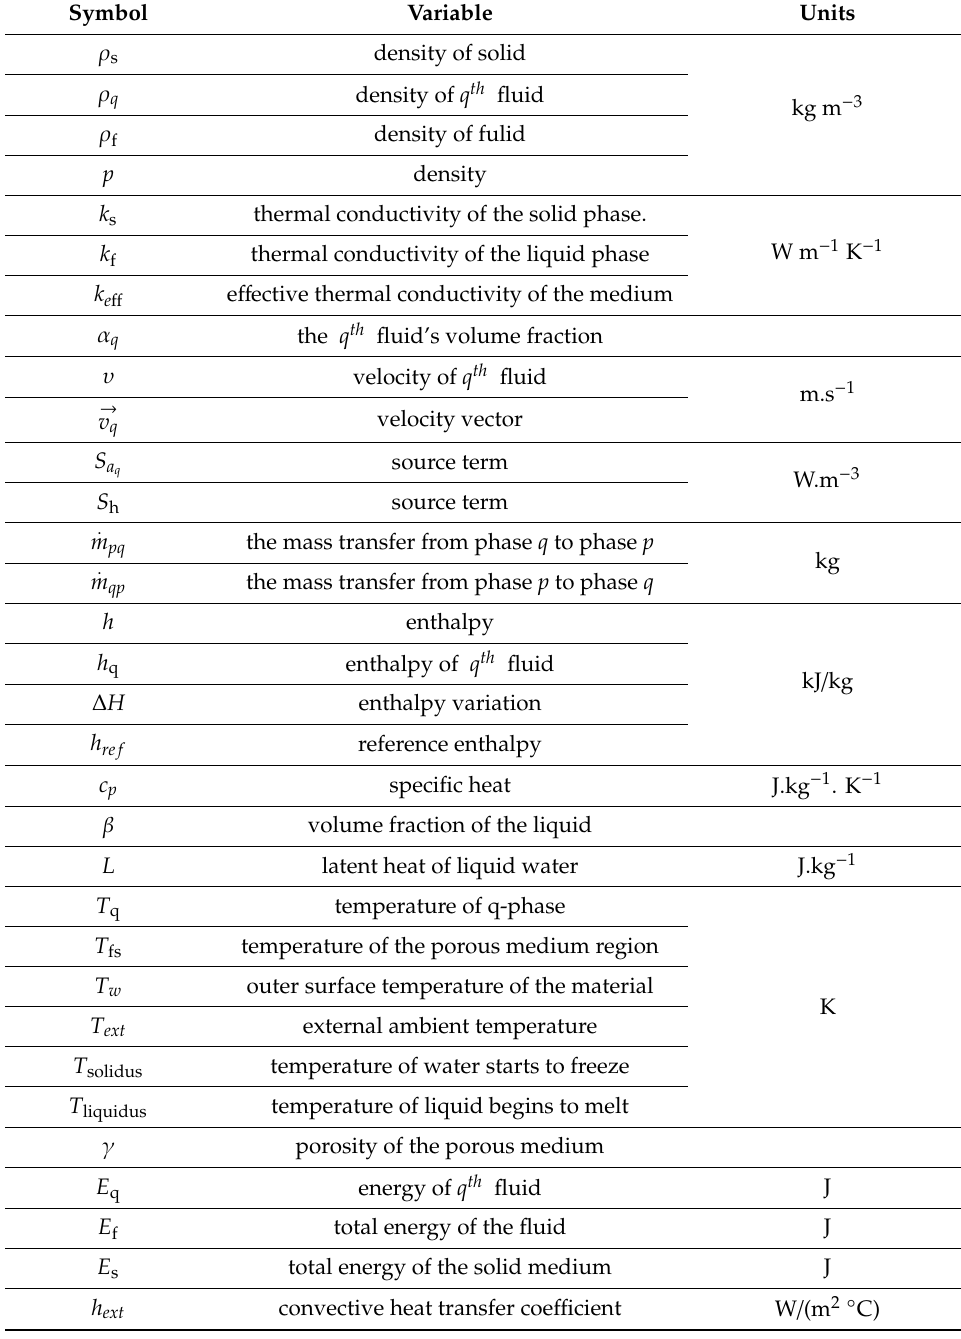
Table A1. The unit of